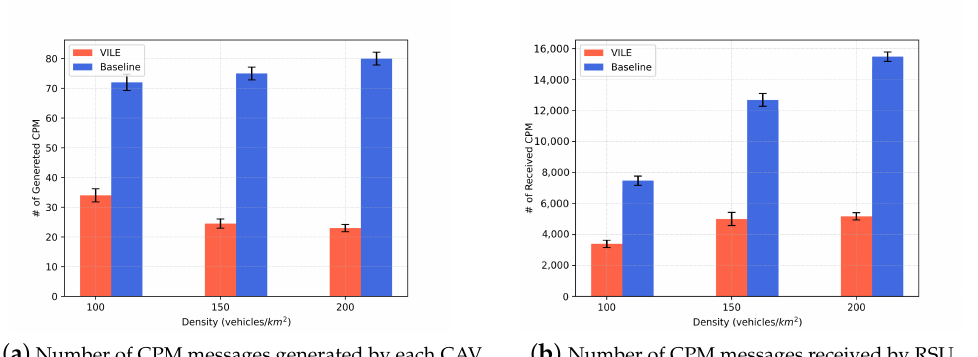
Figure 5. Absolute number of CPM-type messages generated and received by CAVs.